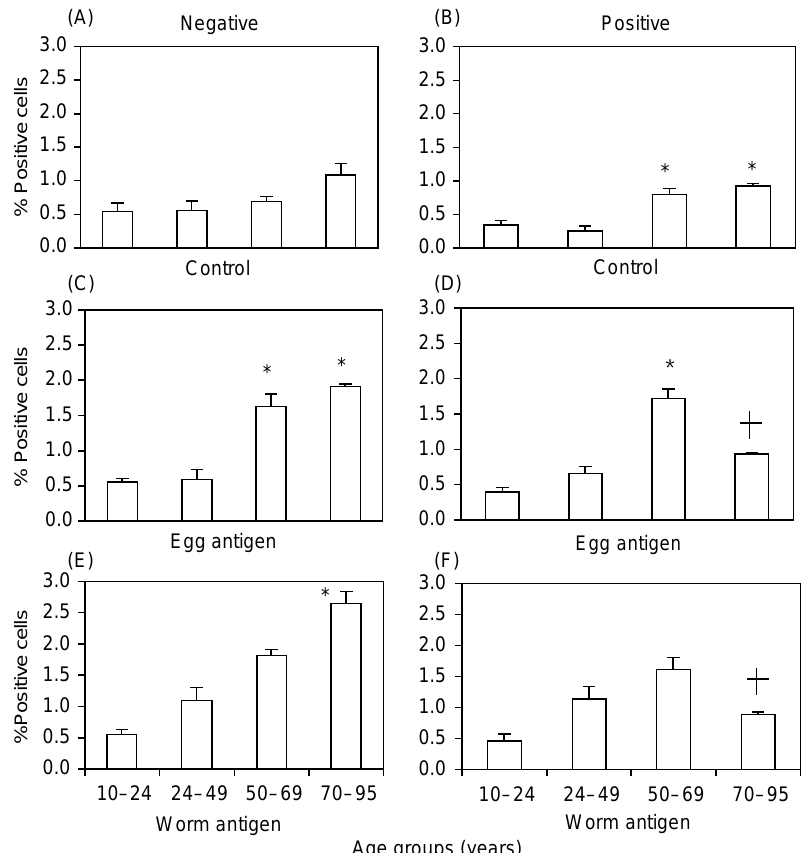
FIG. 1. Frequency of CD16 (cid:2) IFN- g (cid:2) cells according to age and infection status in individuals from areas endemic for schistosomiasis in Brazil. Seventy-three individuals from 10 to 95 years of age were analyzed in a cross-sectional study. Individuals who scored negative in the stool test for S.mansonieggs were taken as negative subjects (A, C, E) and individuals who scored (cid:1) / 100 eggs per gram of feces (epg) were taken as positive subjects (B, D, F). Freshly collected blood cells from both groups of individuals were cultured in complete RPMI for 5 h with either medium alone (control) (A, B), or 25 m g/ml of soluble egg antigen (egg antigen) (C, D) or 25 m g/ml of soluble worm antigen (worm antigen) (E, F). Cells were then stained for CD16 and for IFN- g and analyzed by flow cytometry. Bars represent the average frequency of CD16 (cid:2) IFN- g (cid:2) cells 9 / standard deviation of each age group. A one-way analysis of variance procedure was used to test differences among age groups, *significant differences. Pairs of means of negative and positive individuals at the same age group were tested by Bonferonni post-hoc test, (cid:2) / significant differences. p B /